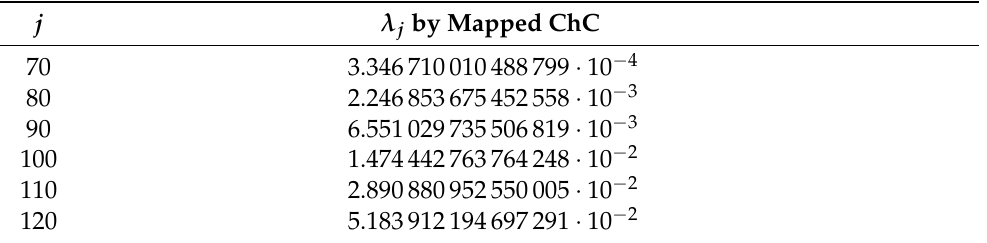
Figure 8. The coefficients of the first four eigenvectors for hydrogen atom eigenproblems (1), (5), and (6) with l : = 1 computed by mapped ChC with scaling factor c : = 2 and N : = 1600. Table 2. High index eigenvalues of hydrogen atom eigenproblems (1), (5), and